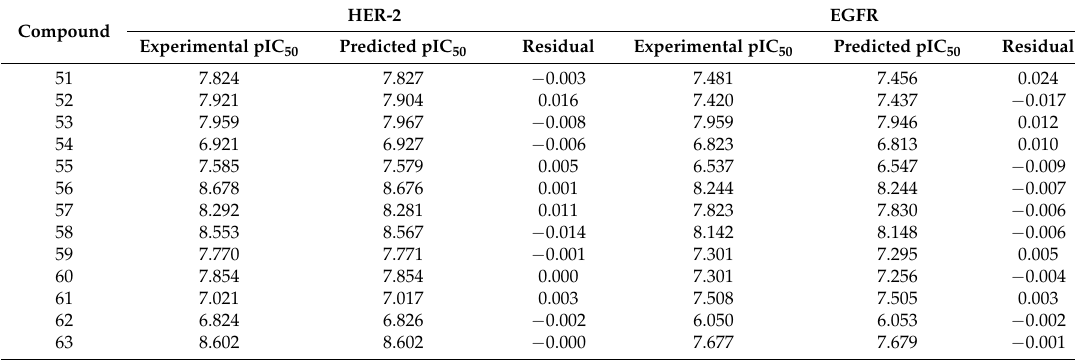
Table 2. Values of experimental and predicted pIC 50 , and residual values for the test set obtained from the CoMFA model for both biological targets. HER-2 Compound